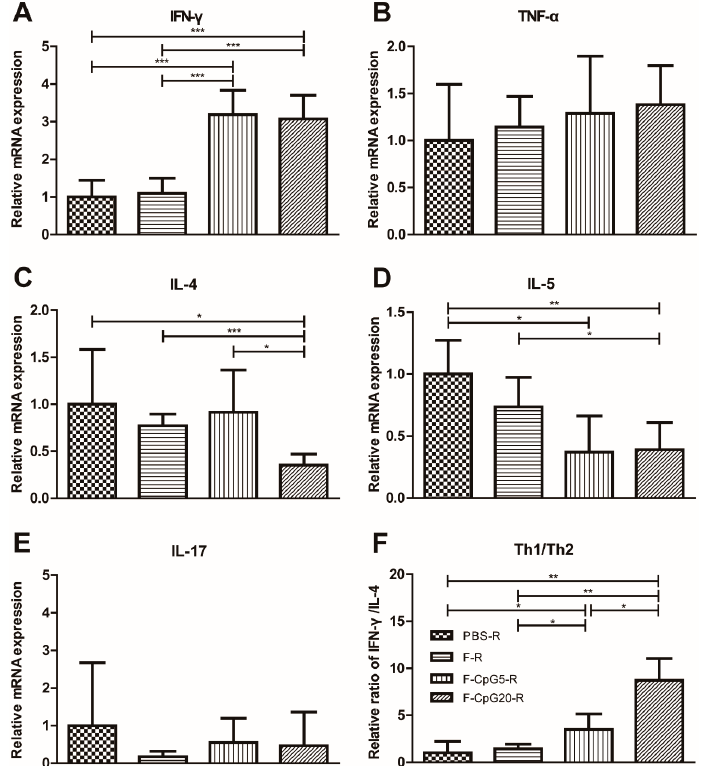
Figure 5. Cytokine production in lungs of immunized mice after 4 day of RSV challenge. BALB/c mice ( n = 5) were immunized 4 times via i.m. route with either pVAX1-F (30 μ g/dose/mouse), pVAX1-CpG5-F (30 μ g/dose/mouse), pVAX1-CpG20-F (30 μ g/dose/mouse), or PBS (NC, 100 μ L/mouse). The vaccinated mice were intranasally challenged with 1 × 10 6 PFU of RSV after 14 days of last immunization. The messenger RNA (mRNA) levels of IFN- γ ( A ); tumor necrosis factor alpha (TNF- α ) ( B ); IL-4 ( C ); IL-5 ( D ); and IL-17 ( E ) were tested with RT-PCR and were normalized relative to